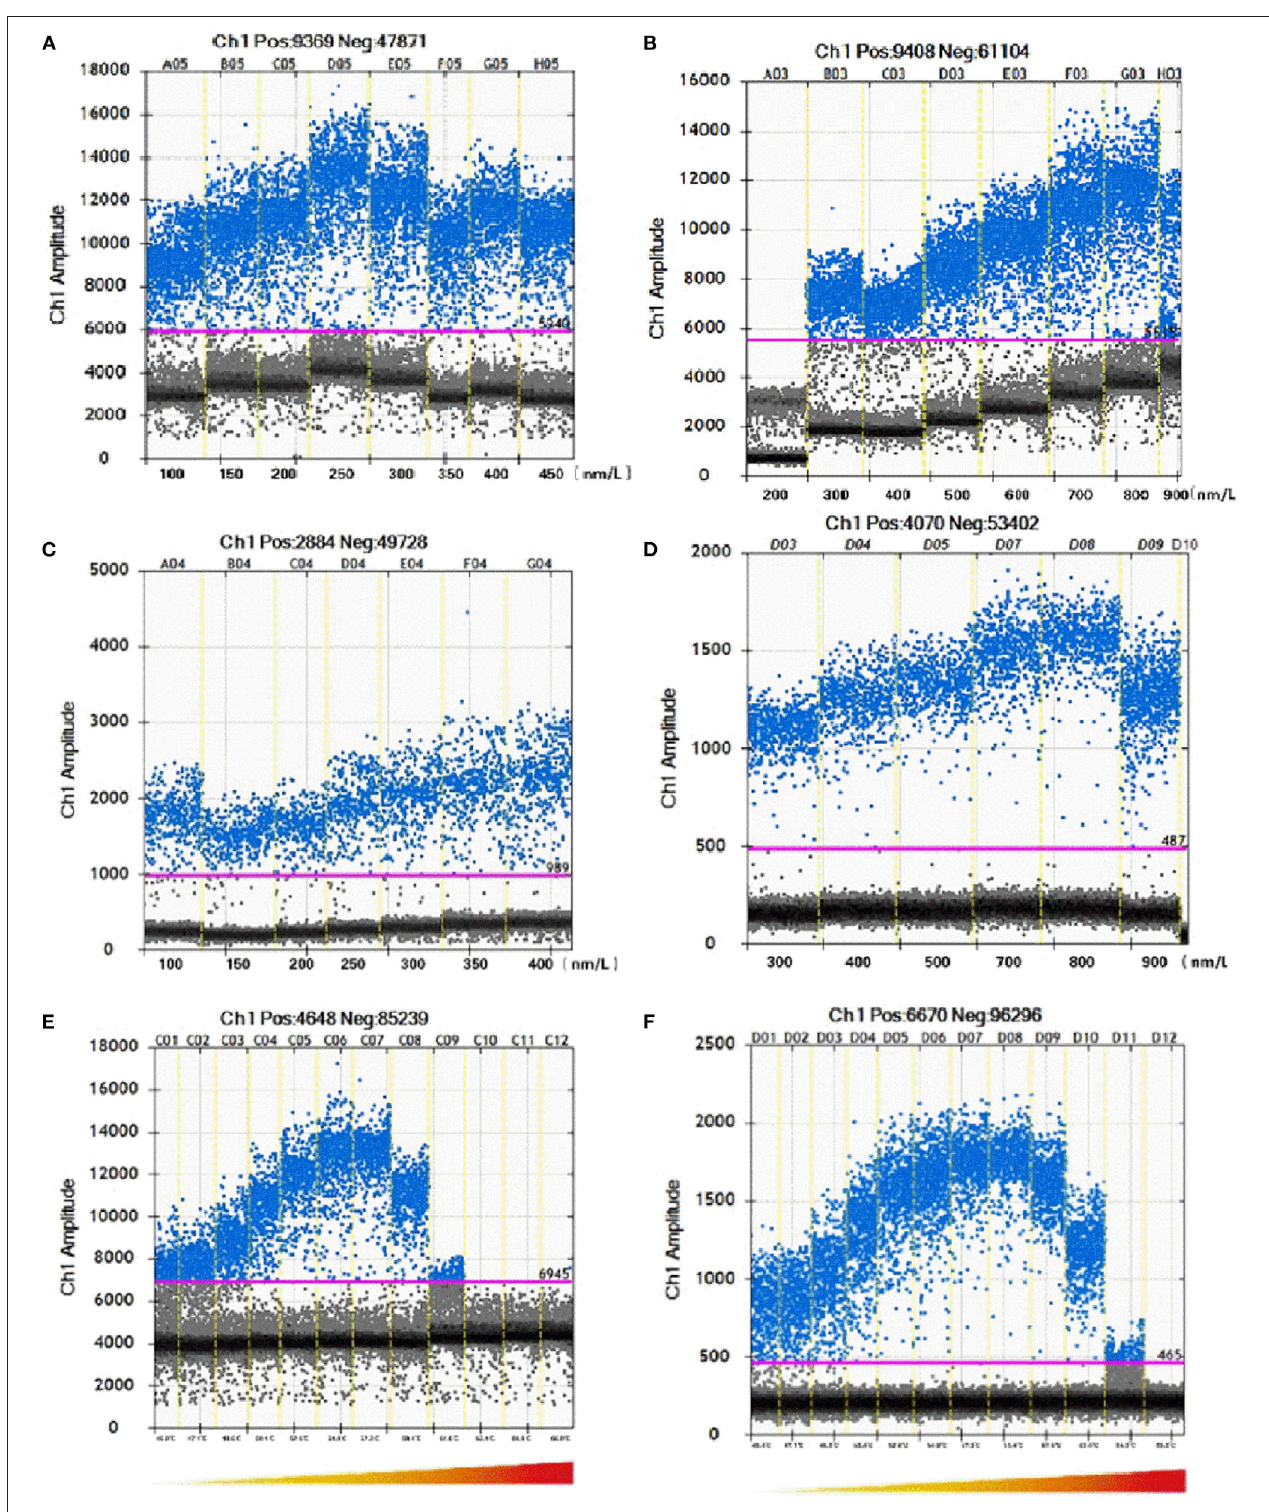
FIGURE 1 | Optimization of ddPCR parameters including concentrations of primers and probes and annealing temperature. The pink line is the threshold. Blue dots represent positive droplets and gray dots represent negative droplets. (A,B) Demonstrated that ddPCR in C. botulinum serotype A with different concentrations of primers and probe. (C,D) Demonstrated that ddPCR in C. botulinum serotype B with different concentrations of primers and probes. (E,F) Demonstrated that ddPCR in C. botulinum serotypes A and B with different annealing temperature.